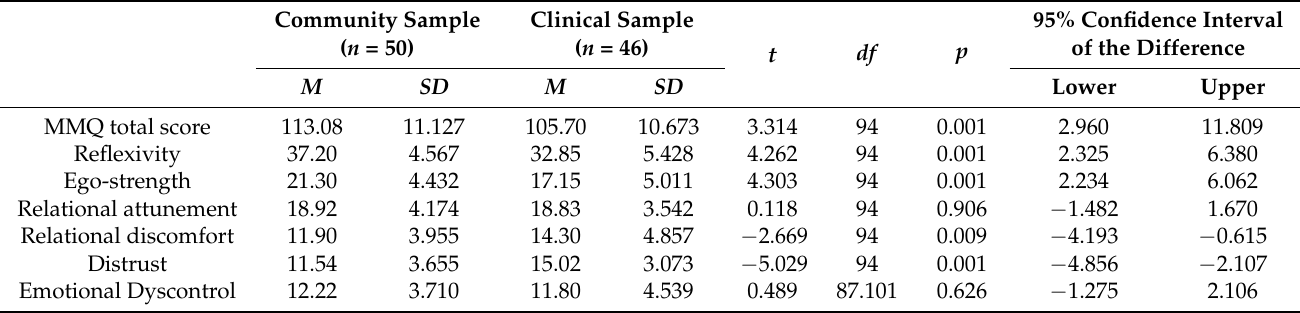
Table 5. Independent samples t-test results for Multidimensional Mentalizing Questionnaire and its subscales’ scores between the community and clinical